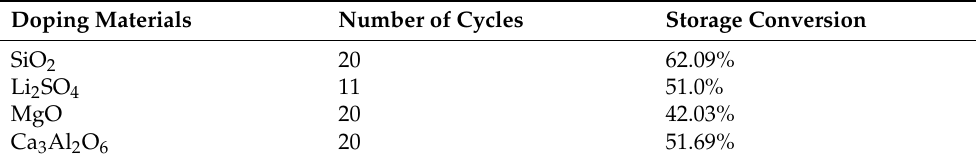
Table 4. Comparison of cycling stability of CaO/CaCO 3 after doping